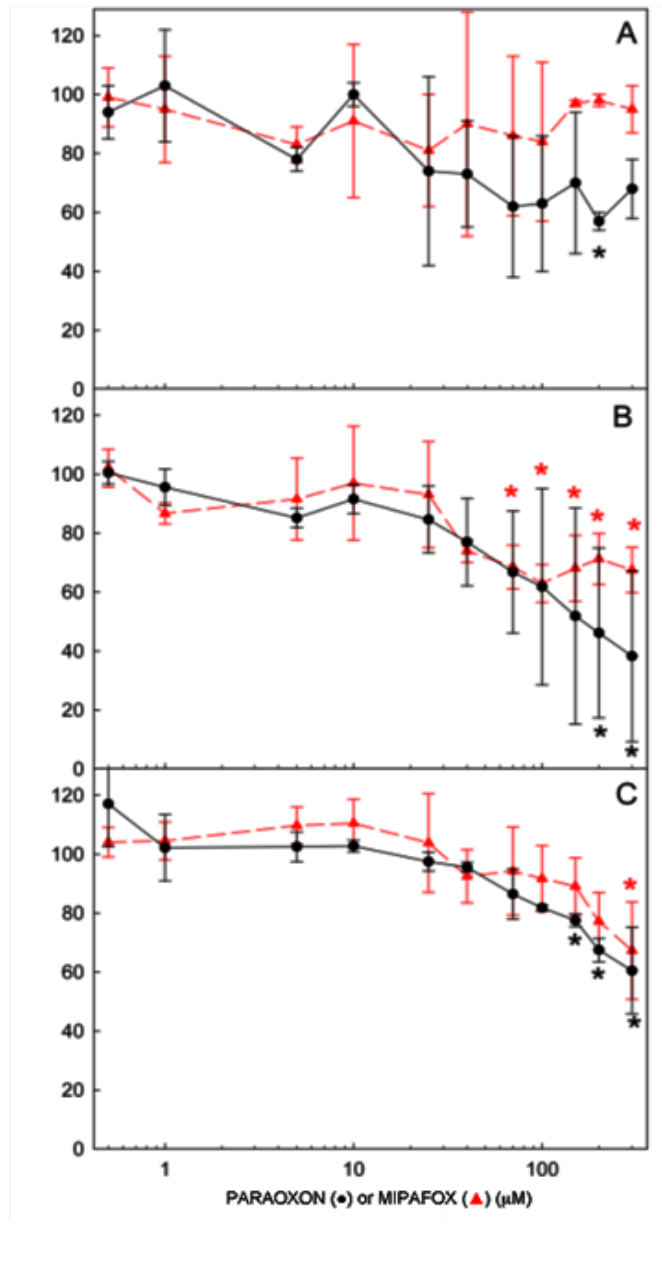
Figure 2. Effect of paraoxon and mipafox on cell viability of NT2 cells during the first stage of neurodifferentiation measured by MTT assay. Cells were exposed to 0.5, 1, 5, 10, 25, 40, 70, 100, 150, 200 and 300 µM of either paraoxon ( ● ) or mipafox ( ▲ ) for 4 days ( A ); 10 days ( B ); and 15 days ( C ). Data represent mean ± SEM of the four independent experiments with 16 independent technical replicates for each experimental condition run. ( * statistically different from the controls for p < 0.05 in both paraoxon and mipafox by Dunnett’s